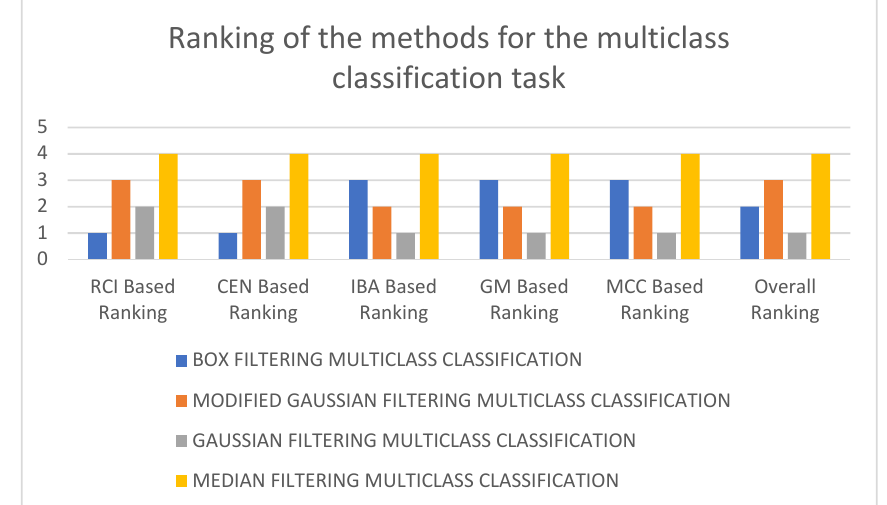
Figure 4. Rankings of different 3D-CNN architectures for the multiclass classification task.